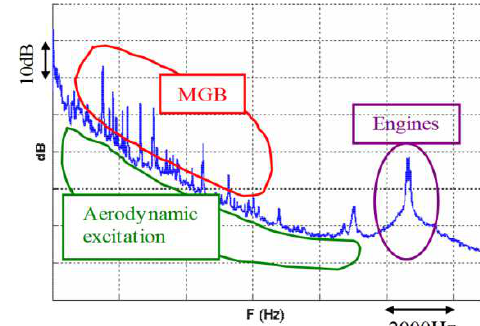
Fig. 1. Power spectral density of helicopter interior noise [1]